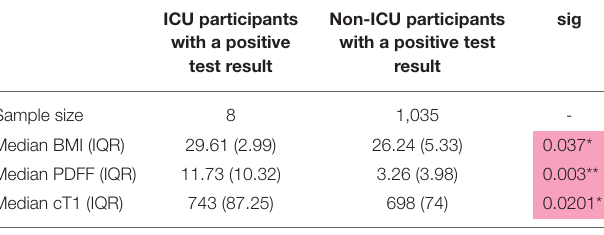
TABLE 2 | Distribution of liver biomarker metrics and BMI in UKB participants who were admitted to ICU 1 week before or 1 month after the COVID-19 test result. ICU participants with a positive